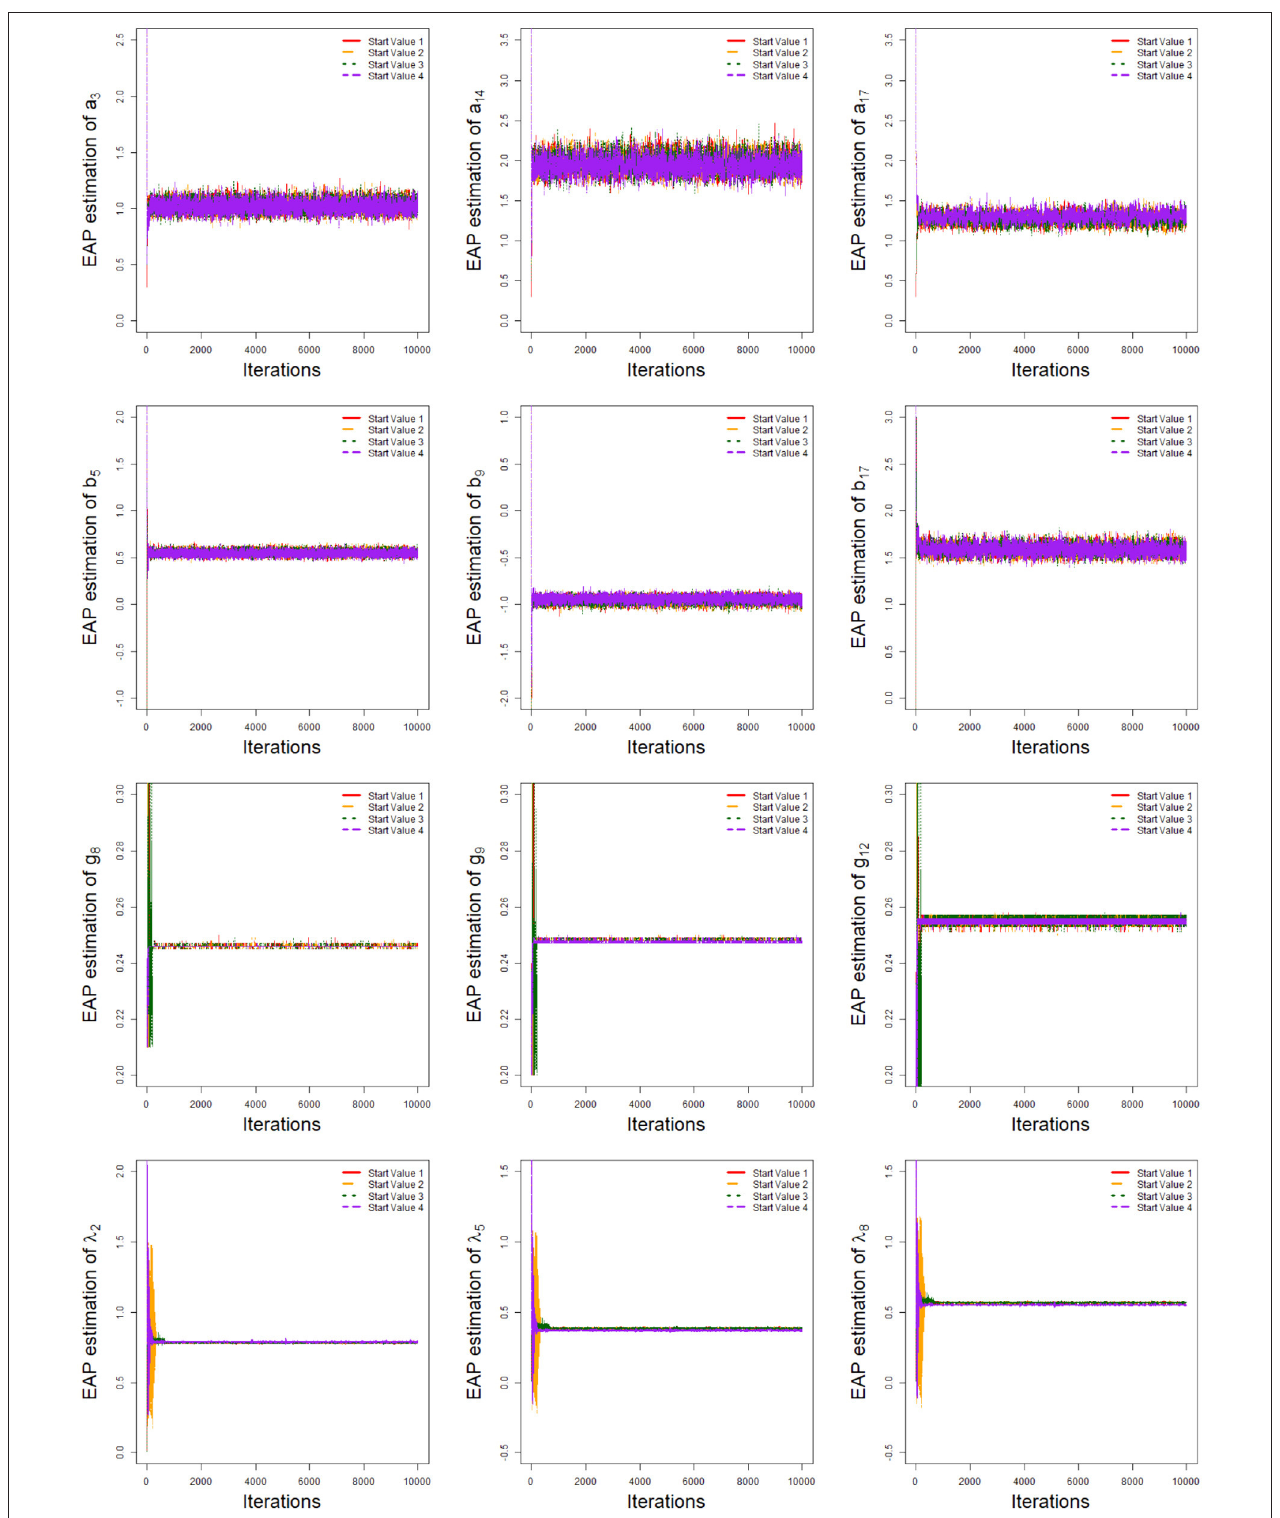
FIGURE 5 | The trace plots of three randomly selected items for the simulation study 1.